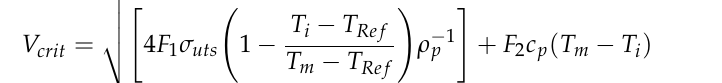
Figure 2. ( a ) SEM image of feedstock powder Ti 3 AlC 2 insert: nano-layered structure of a single particle; ( b ) the correspond-